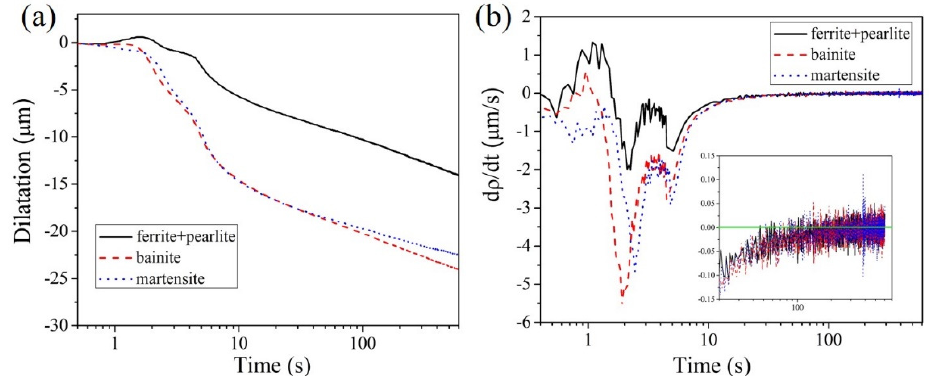
Figure 5. ( a ) The changes in length of the present steel with different initial starting microstructures (ferrite + pearlite, bainite, and martensite) during reverse transformation. Note that the data presented here also include the heating process between Ac1 to 780 °C. ( b ) The rate of changes in length for the reverse transformation from three different microstructures.